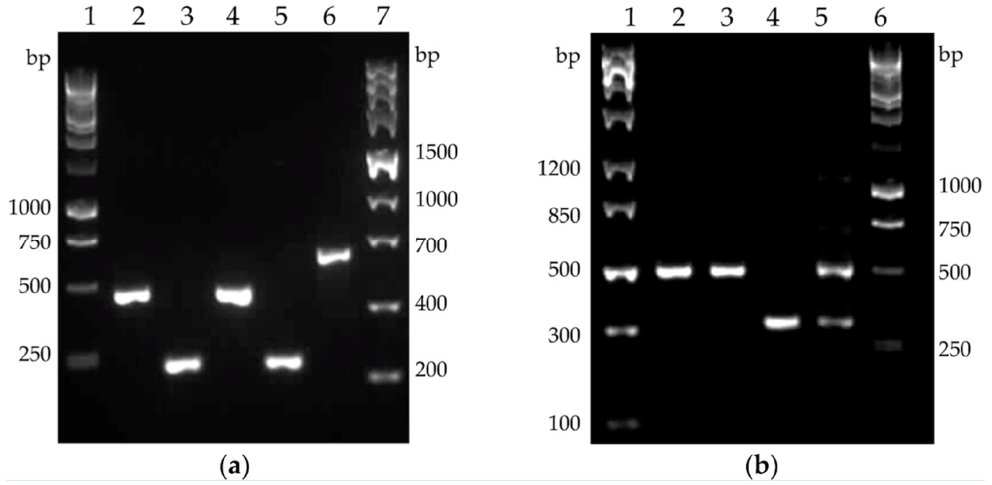
Figure 5. Time course of cellulase activity of B. licheniformis recombinant clones containing the Figure 8. Reverse-transcription PCR revealing the cellulase genes expression. ( a ) Cellulase genes pBES_cel8A construct with a library of signal peptides compared to B. lichenifromis 24 transformed expressed in B. licheniformis host and recombinant clone 34. Lanes and samples: (1) Perfect with pBE-S vector (control). The data are mean values from two batch processes.